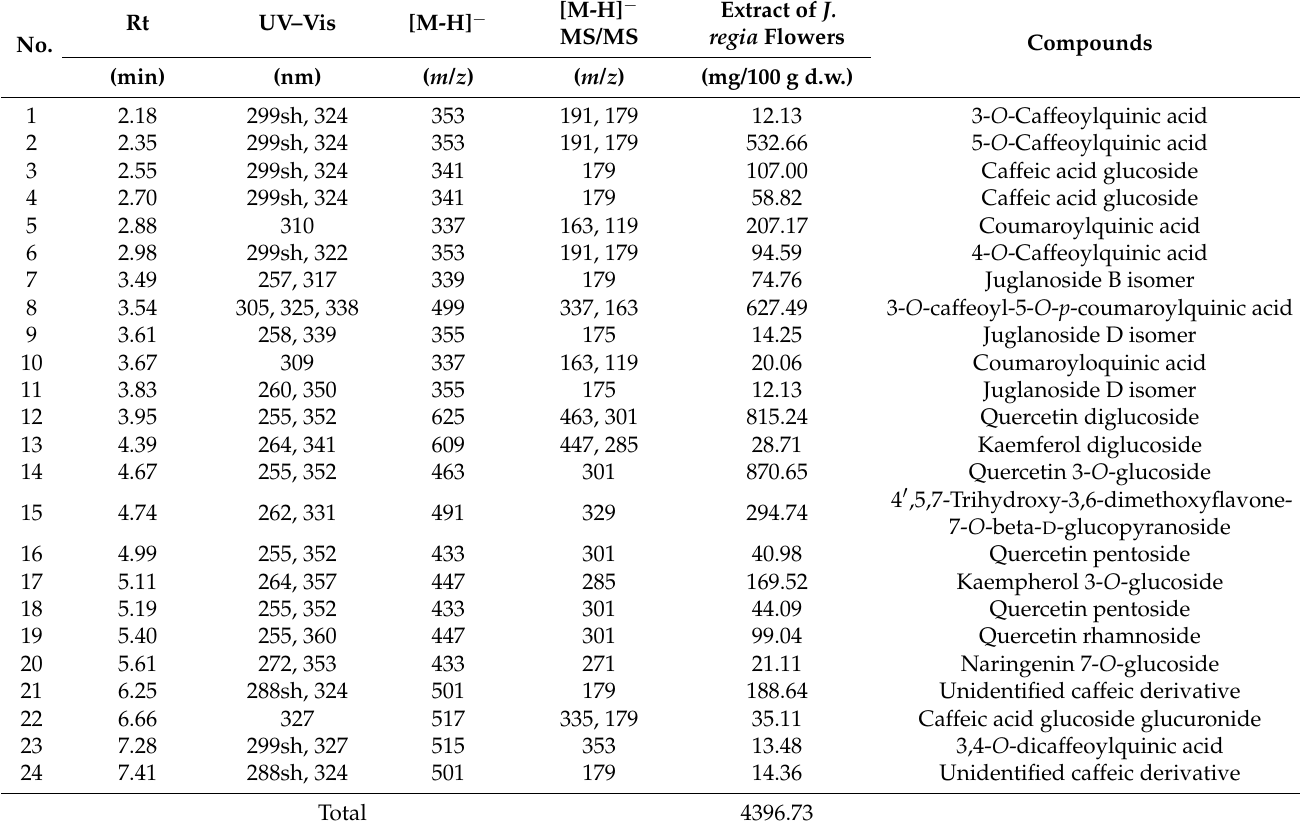
Table 5. The phenols identified (tentatively) in J. regia male flowers by means of